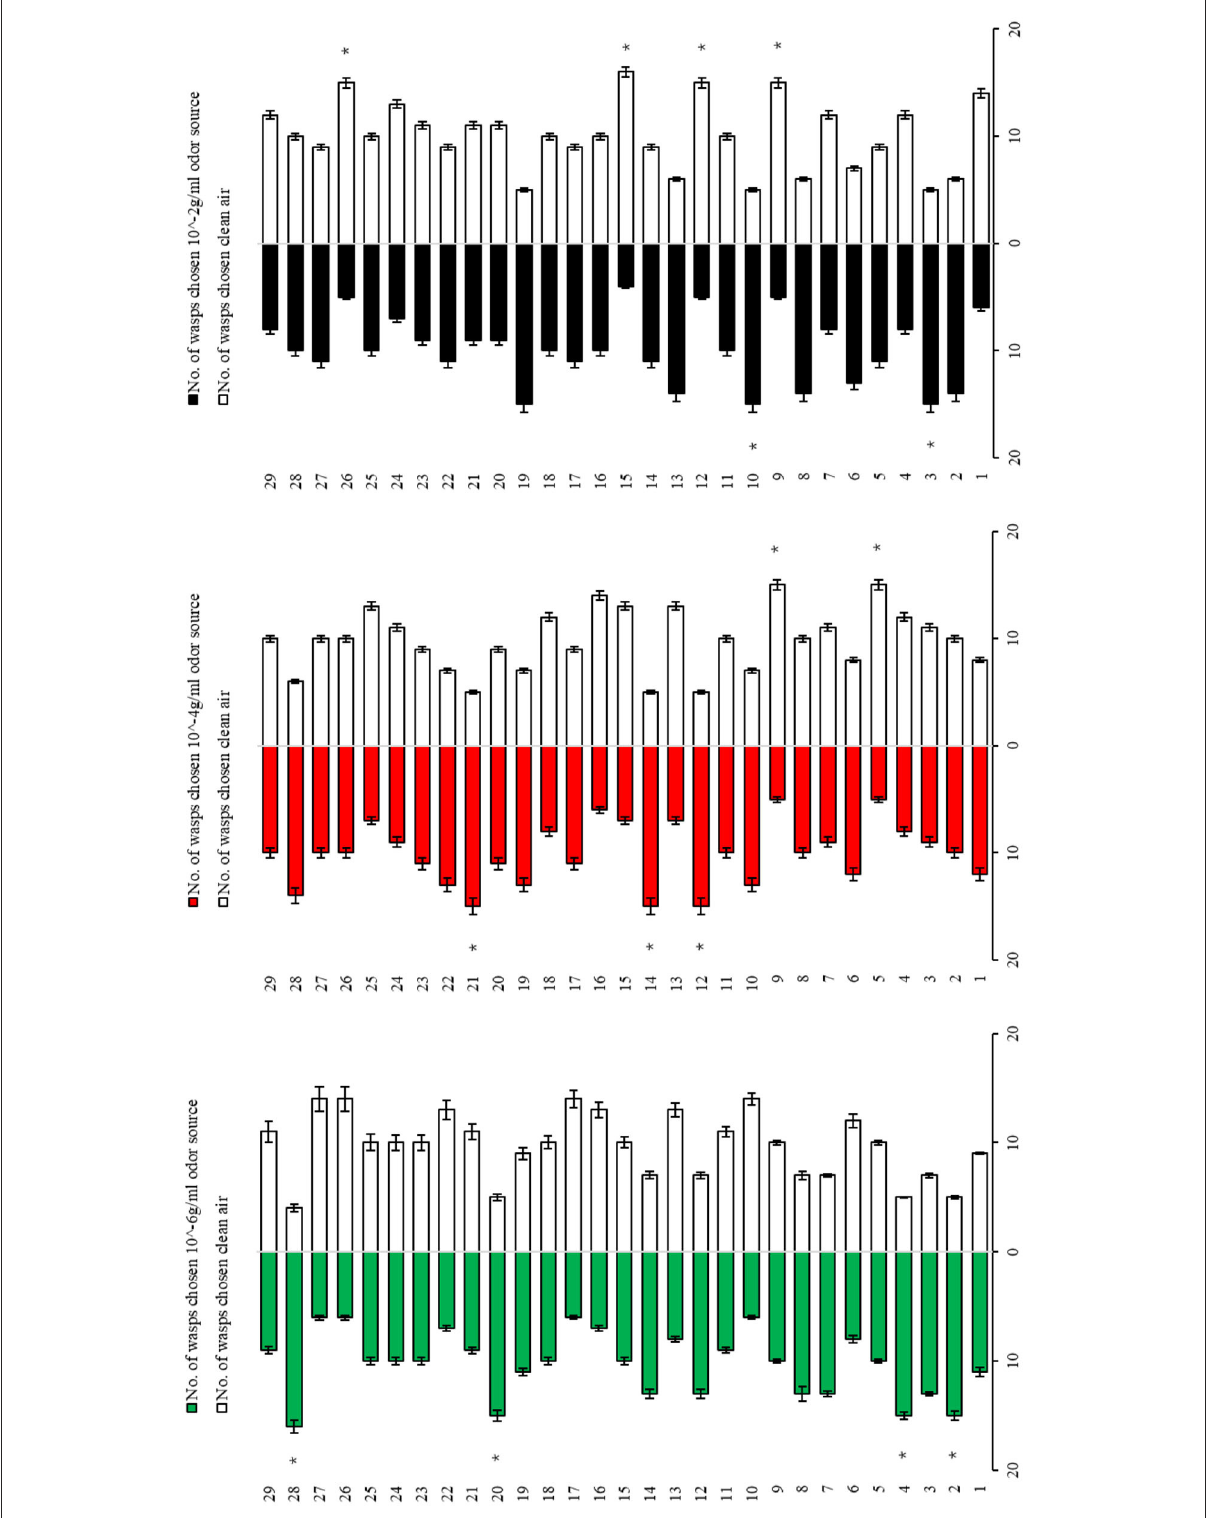
FIGURE1 Attraction of Aphelinus sp. to three dosages of 27 synthetic components (plus two mixtures) identified from tea shoot–aphid complexes and/or tea flowers. 1, linalool; 2, trans -2-hexenal; 3, cis -3-hexen-1-ol; 4, benzaldehyde; 5, methyl salicylate; 6, geraniol; 7, indole; 8, cis